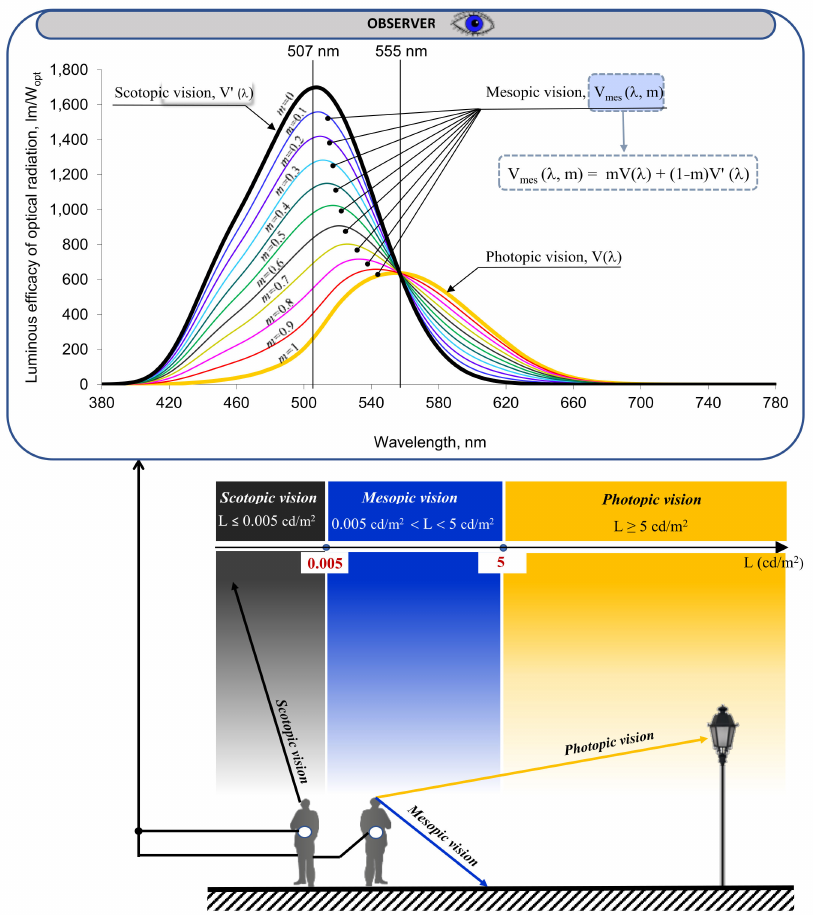
Figure 6. Curves of the luminous efficacy of monochromatic radiation as a function of the wavelength for photopic V( λ ), mesopic V mes ( λ ), and scotopic V’( λ ) vision, along with an illustrative scheme of the conditions under which adaptation of the organ of vision to particular types of vision